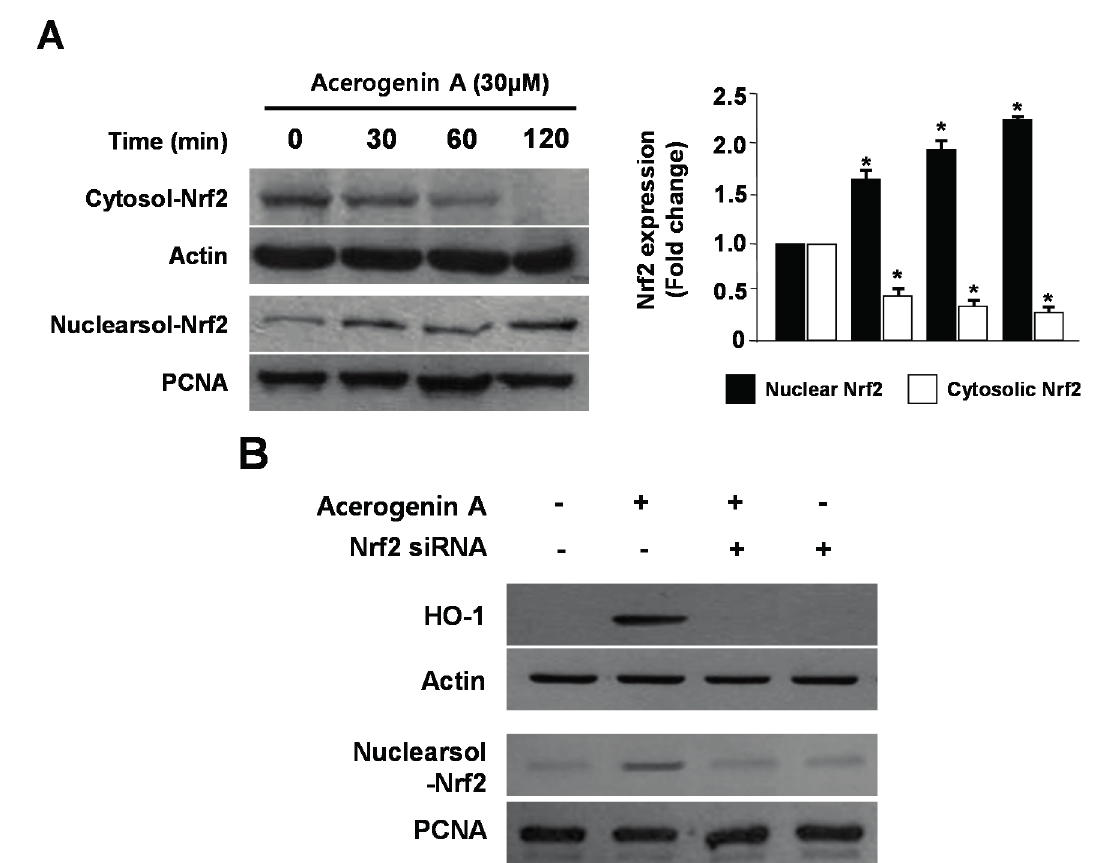
Figure 4. The effects of acerogenin A on the nuclear translocation of Nrf2 ( A ) and Nrf2-mediated HO-1 ( B ) in HT22 cells. HT22 cells were treated with 30 μ M of acerogenin A for 0, 30, 60, and 90 min ( A ). The nuclei were fractionated from the cytosol by using PER-Mammalian Protein Extraction Buffer, as described in the Experimental Section ( A